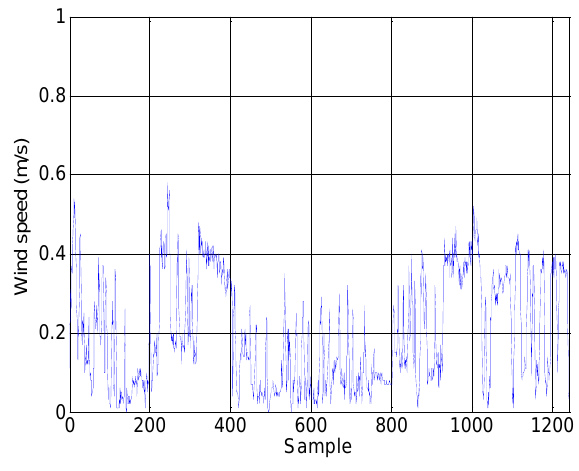
Figure 5. Raw wind speed samples obtained during the exploration.